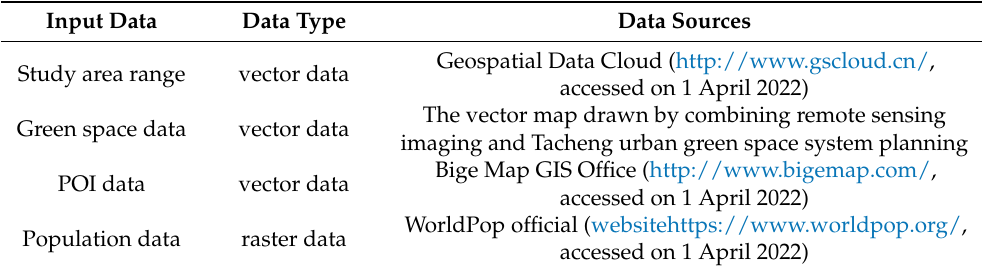
Table 2. Input data source summary